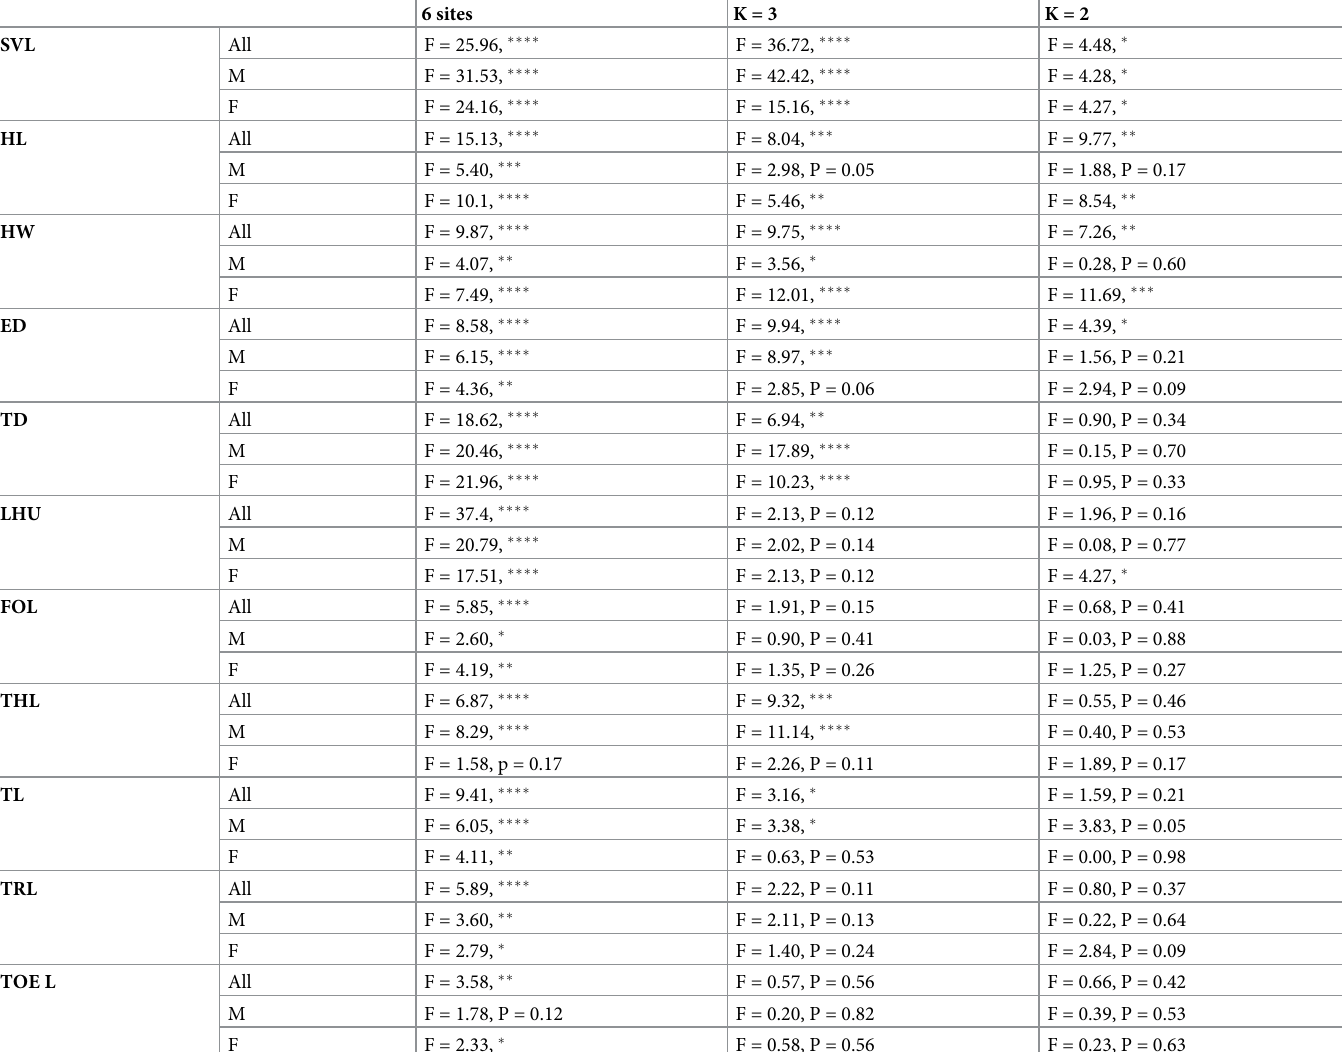
Table 1. Comparisons of morphological variables between the six sites and between the genetic subpopulation clusters (K = 2 and K = 3 STRUCTURE models) based on